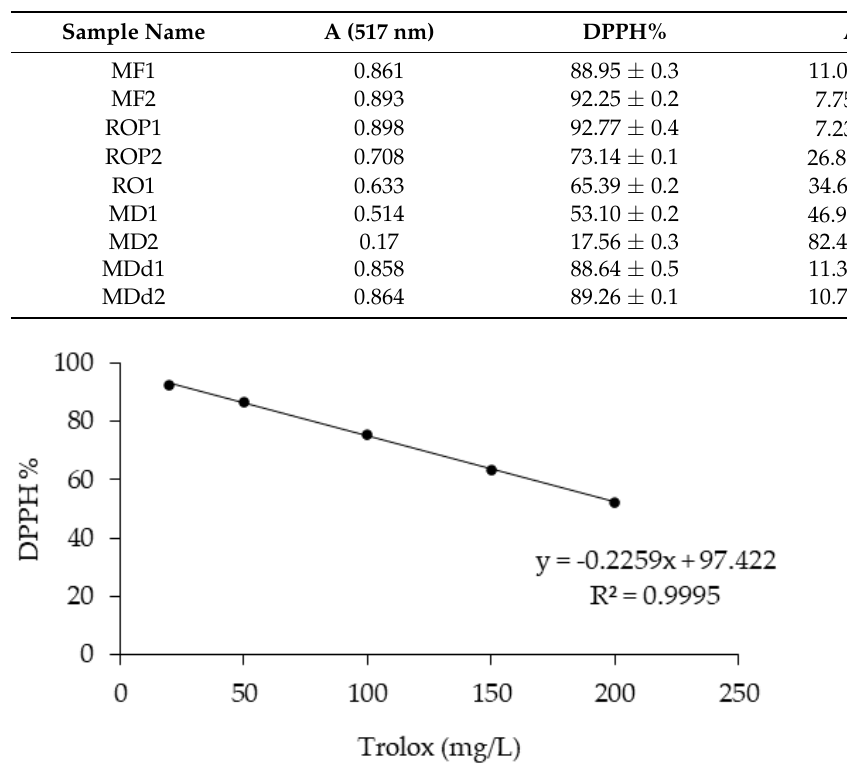
Figure 7. Trolox calibration curve (concentrations ranging from 20 to 200 mg/L).